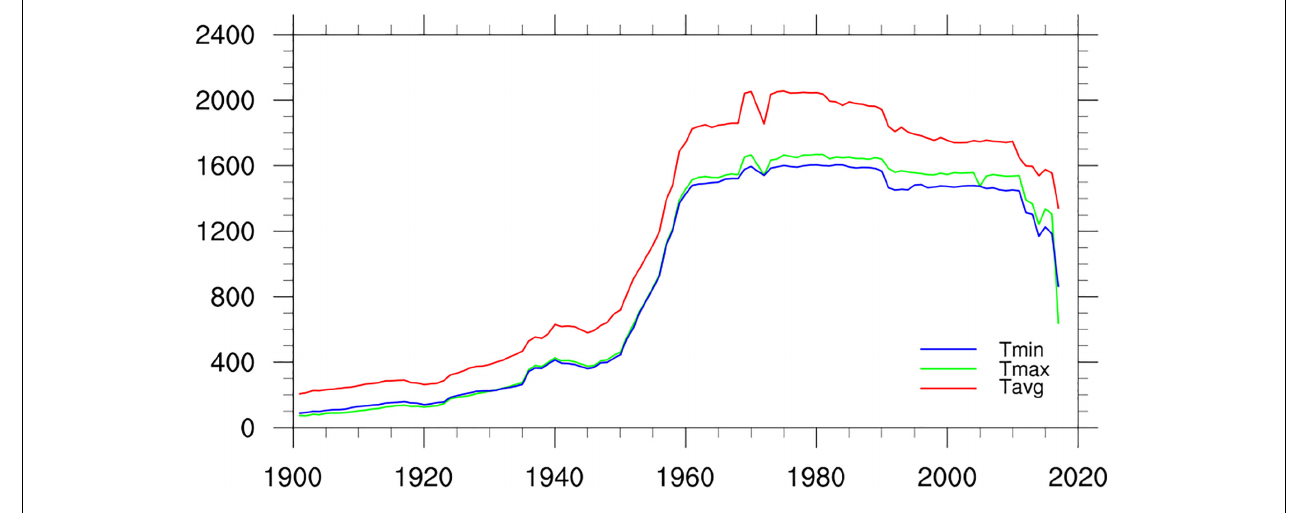
FIGURE 2 | The number of stations in gridding region over